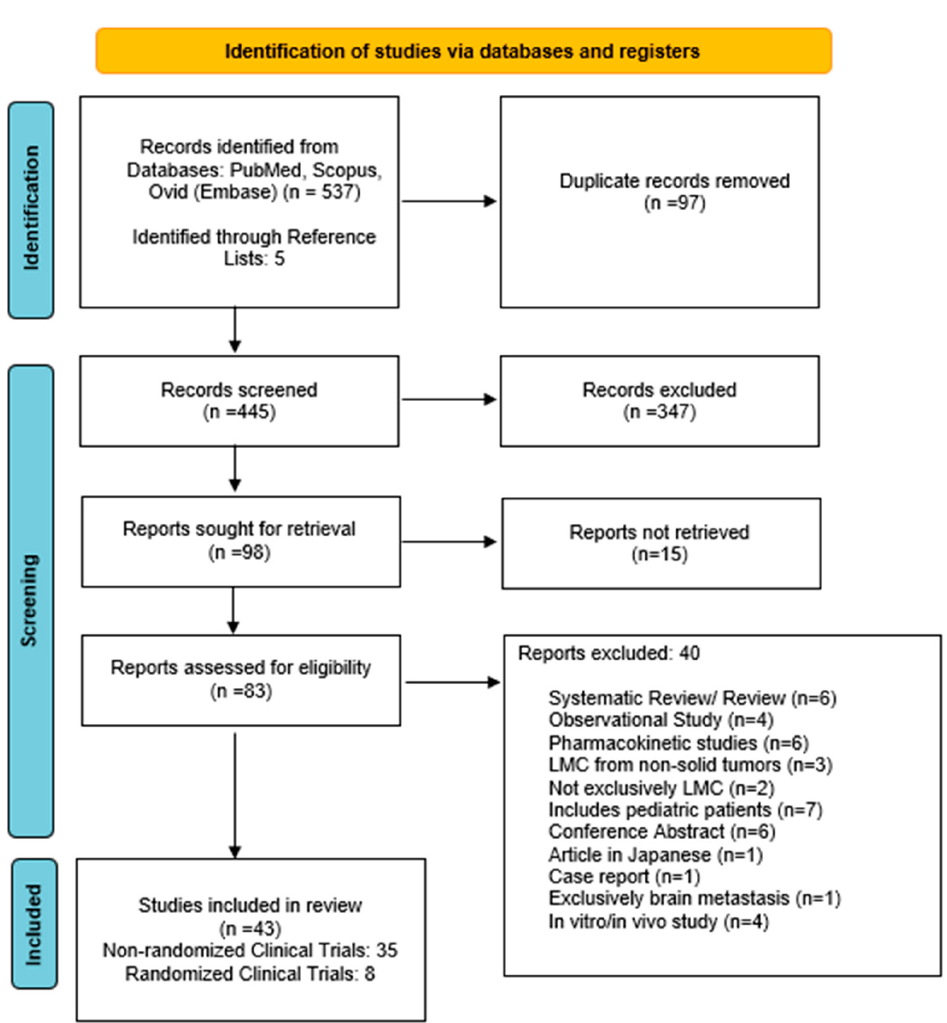
Figure 1. Preferred Reporting Items for Systematic Reviews and Meta-Analysis (PRISMA) search strategy.